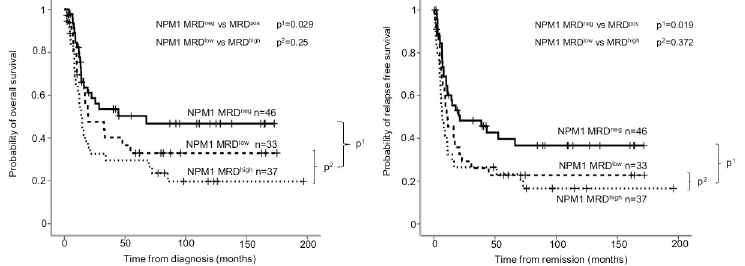
Fig 3. Probability of overall survival and relapse free survival according to NPM1 MRD after induction. On both panels (A: overall survival; B: relapse free survival), the outcome of NPM1 MRD-negative (MRD neg VAF < 0.01–0.05% depending on NPM1 mutation type) and MRD-positive (MRD pos VAF > 0.01–0.05%) subgroups are shown with the associated p 1 value. The NPM1 MRD-positive subgroup was further divided in MRD low-positive (MRD low VAF = 0.01–0.2%) and MRD high-positive (MRD high VAF > 0.2%) subgroups, and compared with p 2